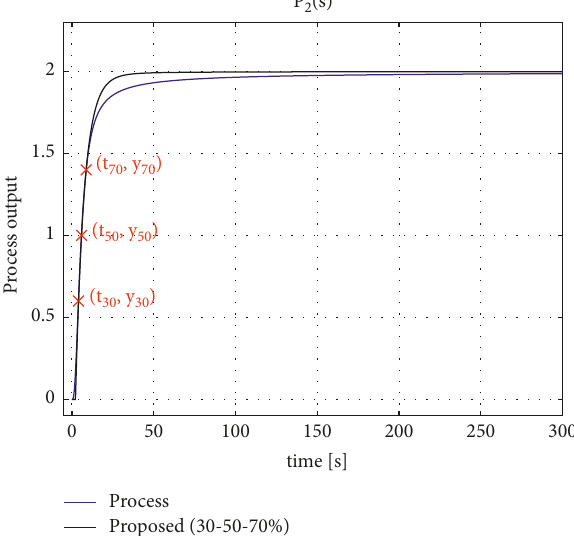
Figure 19: Process reaction curve and FFOPDT model method # 3 (20–50–80%) step response for process P 2 .